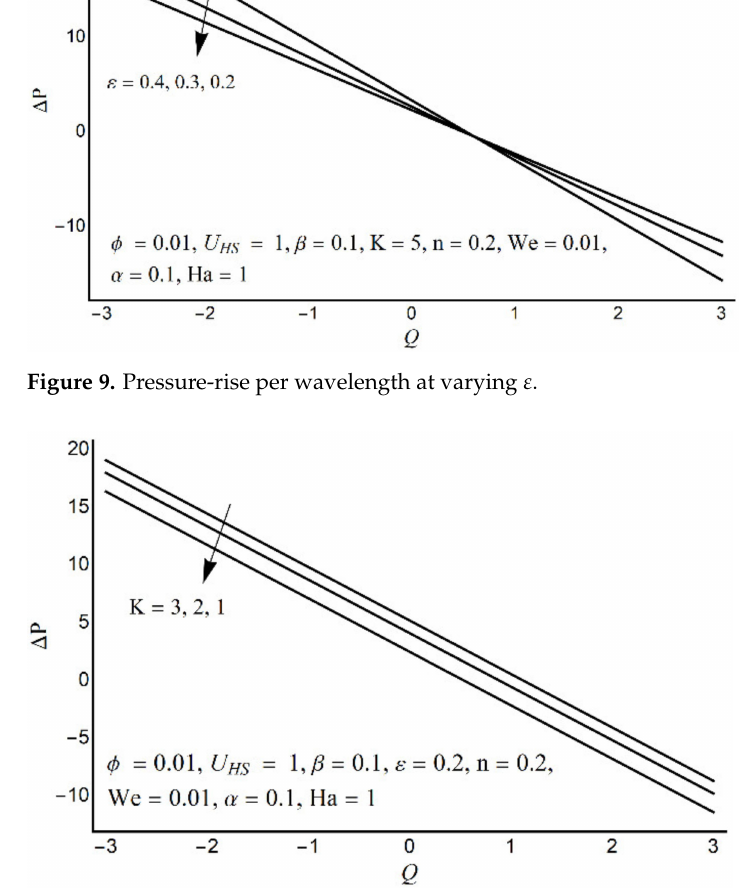
Figure 10. Effect of variation in K on pressure rise per